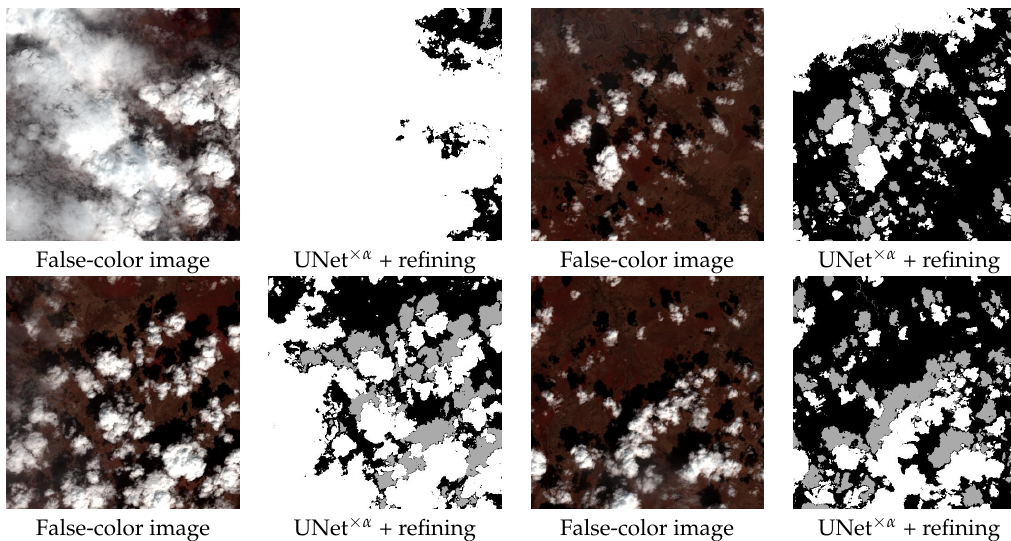
Figure 1. Examples of Refined UNet for cloud and cloud shadow segmentation. It is observed that Refined UNet can delineate boundaries of clouds and shadows sharper and more precisely, which overcomes the inflation of given ground